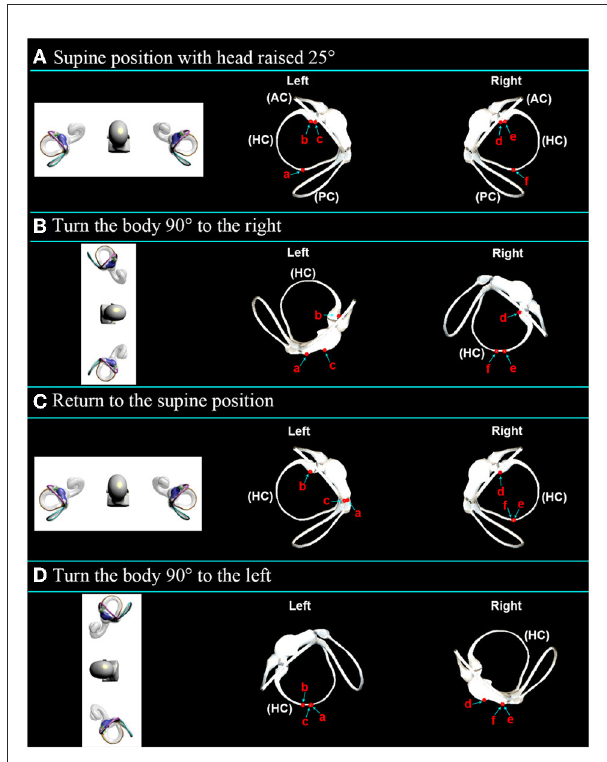
FIGURE5 Movement of the otoliths in the horizontal semicircular canal in the supine roll test. (A) The stable position of otoliths in the supine position with the head raised 25 ◦ . (B) The stable position of otoliths after turning to the right at 90 ◦ . (C) The stable position of otoliths after returning to the supine position. (D) The stable position of otoliths after turning 90 ◦ to the